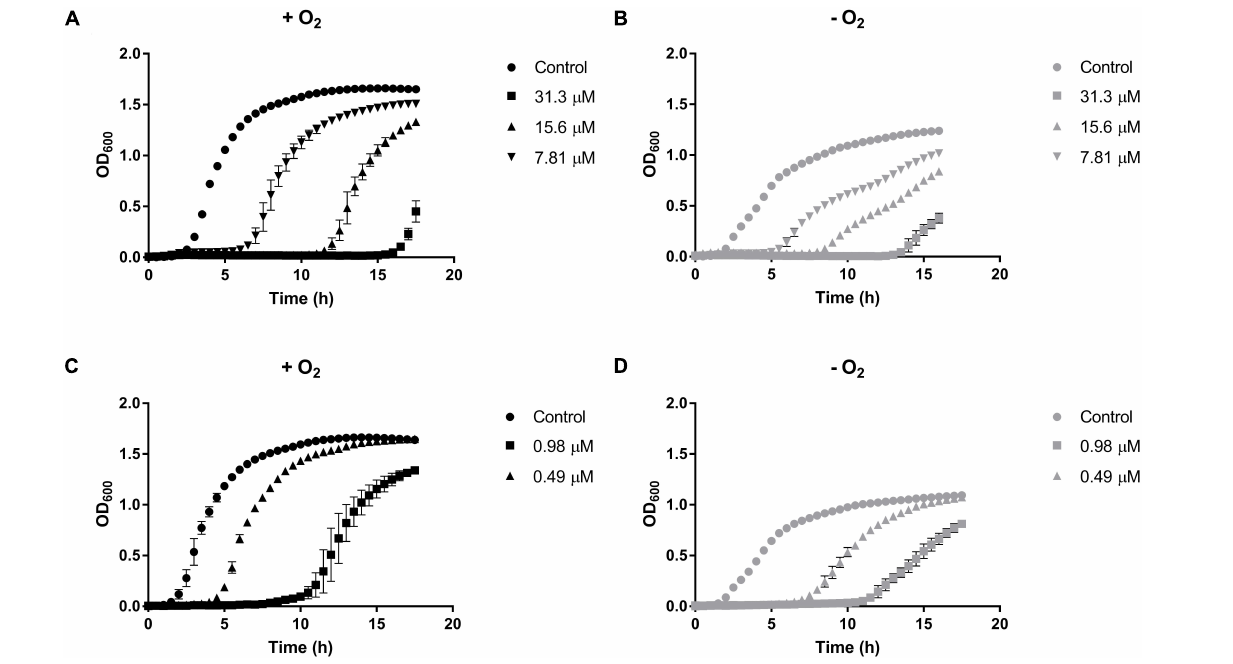
FIGURE 1 | Growth curves of Enterobacter cloacae MF01 exposed to sublethal concentrations of HAuCl 4 or K 2 TeO 3 under aerobic and anaerobic conditions. Cells were grown in LB medium in the absence or presence of HAuCl 4 (A,B) or K 2 TeO 3 (C,D) both under aerobic (A–C) and anaerobic conditions (B,D) . Each point corresponds to the average of six independent tests ±